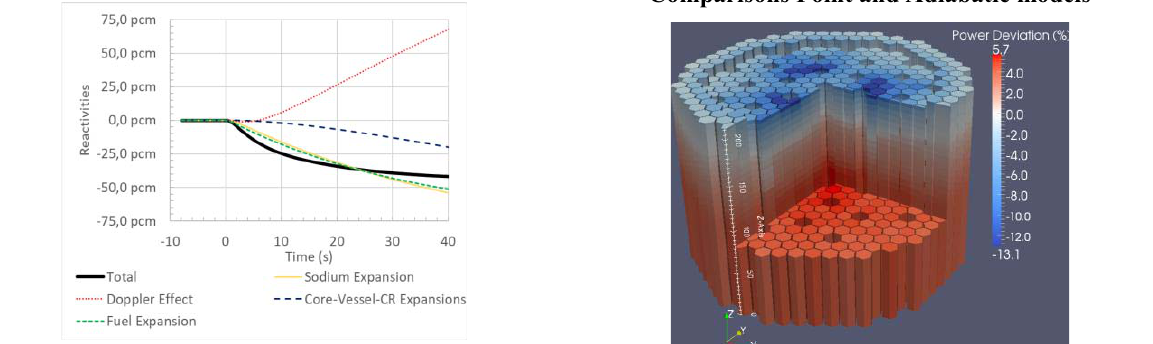
Figure 7 : ULOF Scenario: Total core reactivity– Comparisons Point and Adiabatic models